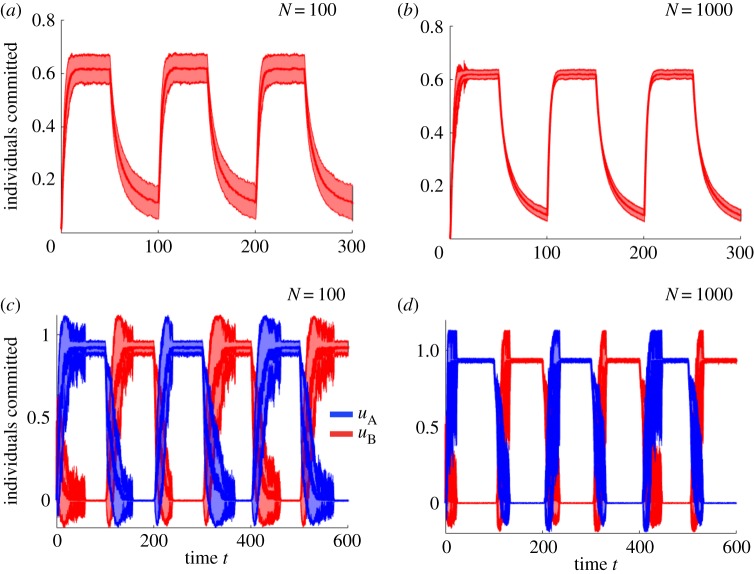
Mean and standard deviation of stochastic simulations of the single-feeder equation (B 2) and two-feeder equation (B 3) in the case of temporal switching of feeder quality occurring at T = 50 min intervals. In the single-feeder model, for (a) N = 100 and (b) N = 1000, near periodic switching of the mean trajectory of simulations (lines) is not far from the behaviour of the mean-field system equation (2.3). Other model parameters are α~=0.2, β~=0.2 and γ~=0.2. Standard deviations (shaded regions) decrease as the system size is increased. Similar trends are apparent in the statistics of the two-feeder finite-sized models with discriminate stop signalling (c) N = 100 and (d) N = 1000. Other model parameters are α~=2, β~=2, γ~=0.1, ρ~=1, T = 100 min and τ = 0.